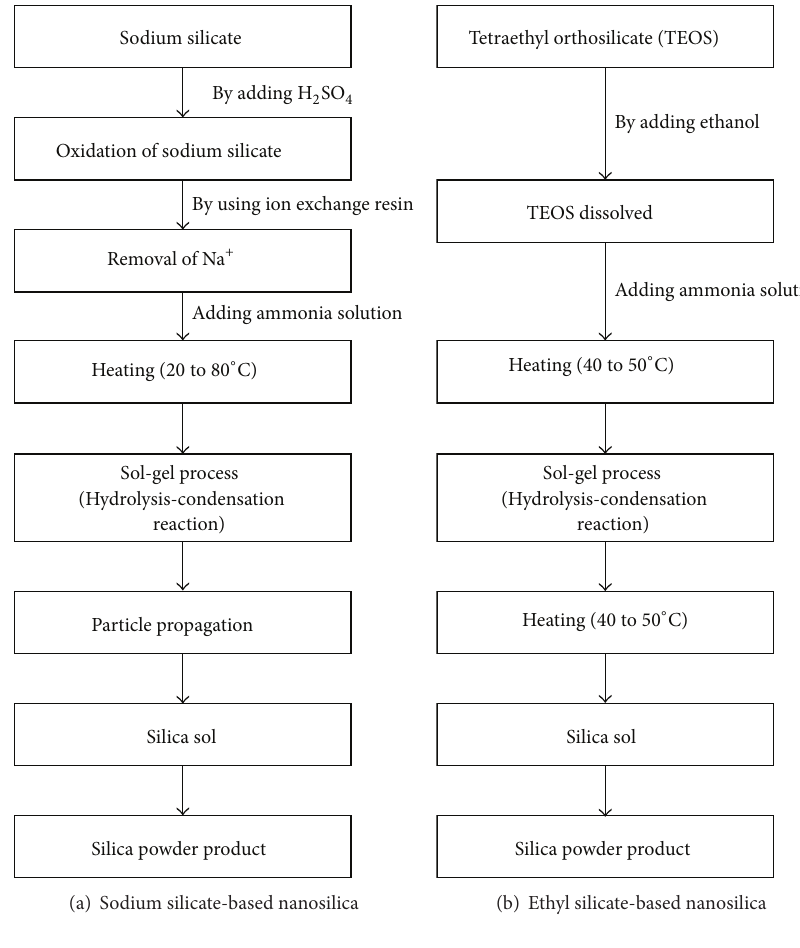
Figure 1: Synthesis process for nanosilica products.